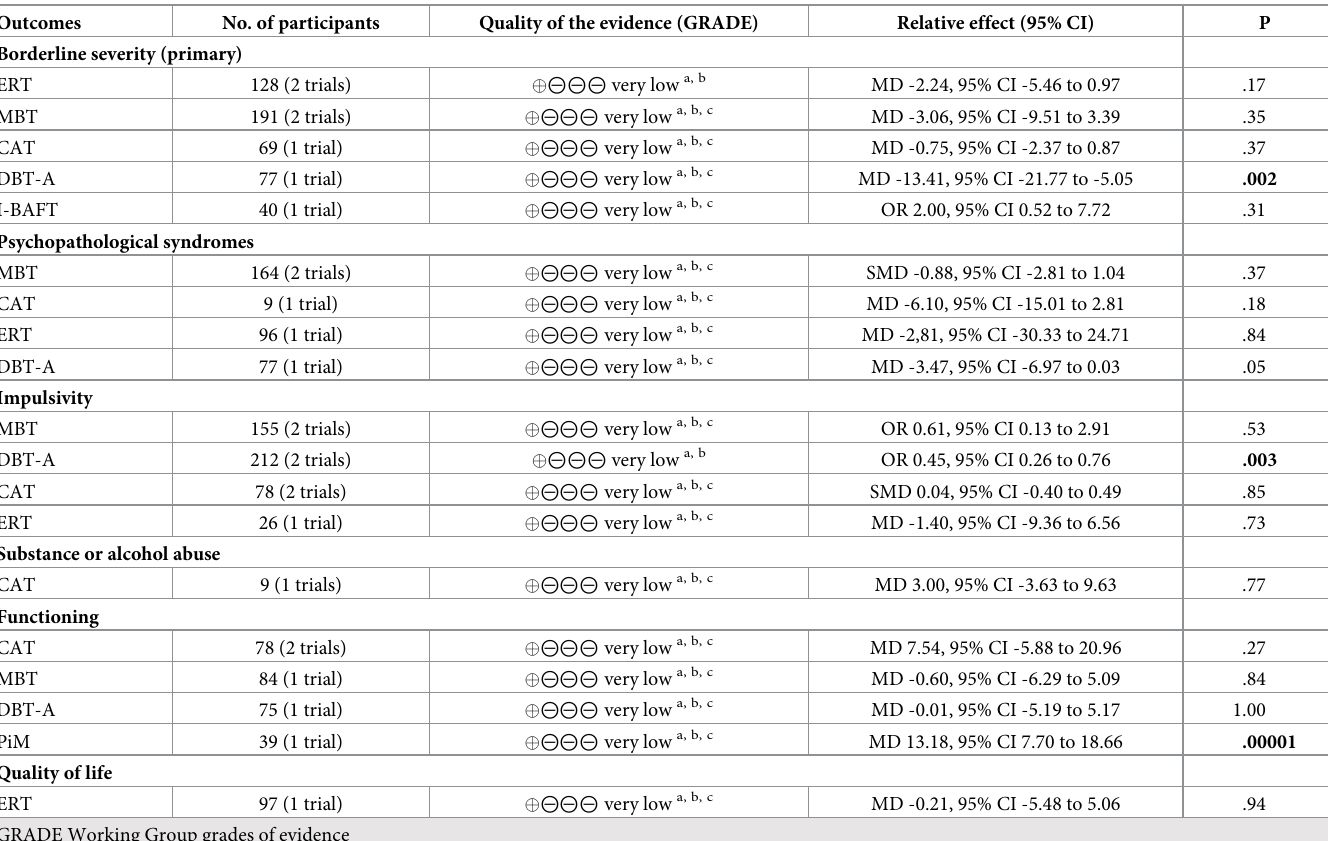
Table 5. Summary of findings table (EOT